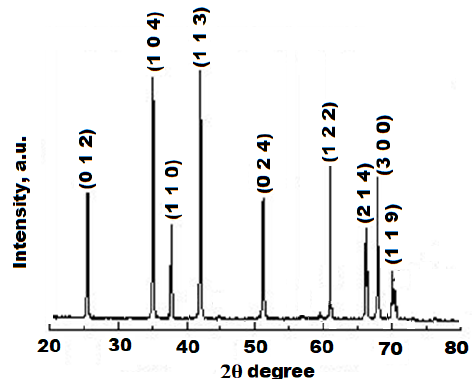
Figure 3. ( a ) SEM and ( b ) EDX images of biosynthesized Al 2 O 3 nanoparticles. Figure 2. XRD spectrum of biosynthesized Al 2 O 3 nanoparticles. Figure 2. XRD spectrum of biosynthesized Al 2 O 3 nanoparticles.